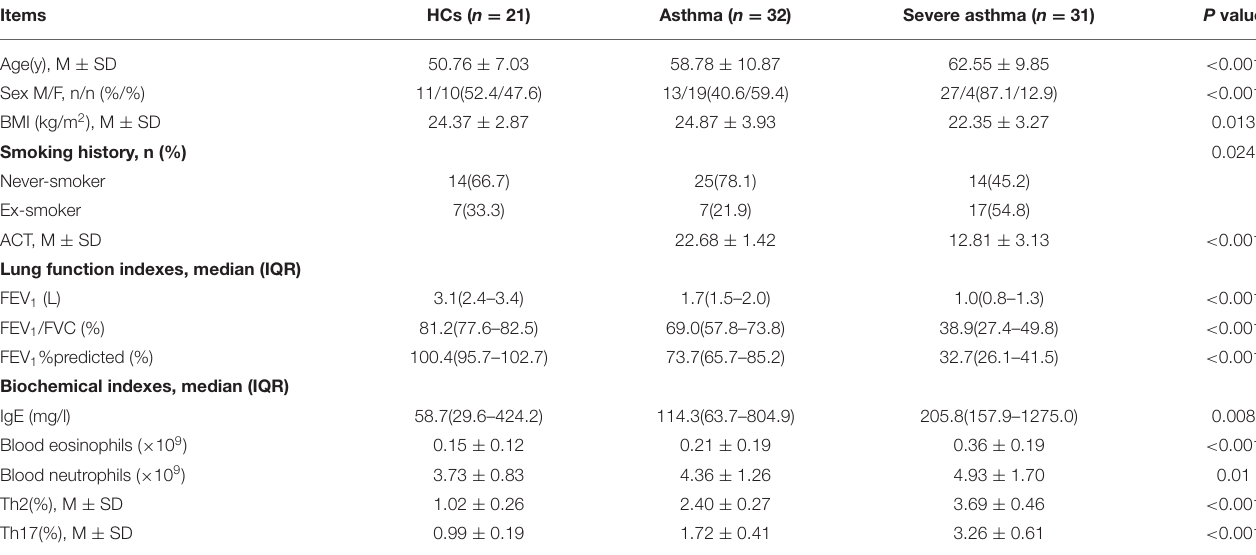
TABLE 1 | Clinical characteristics of participants.